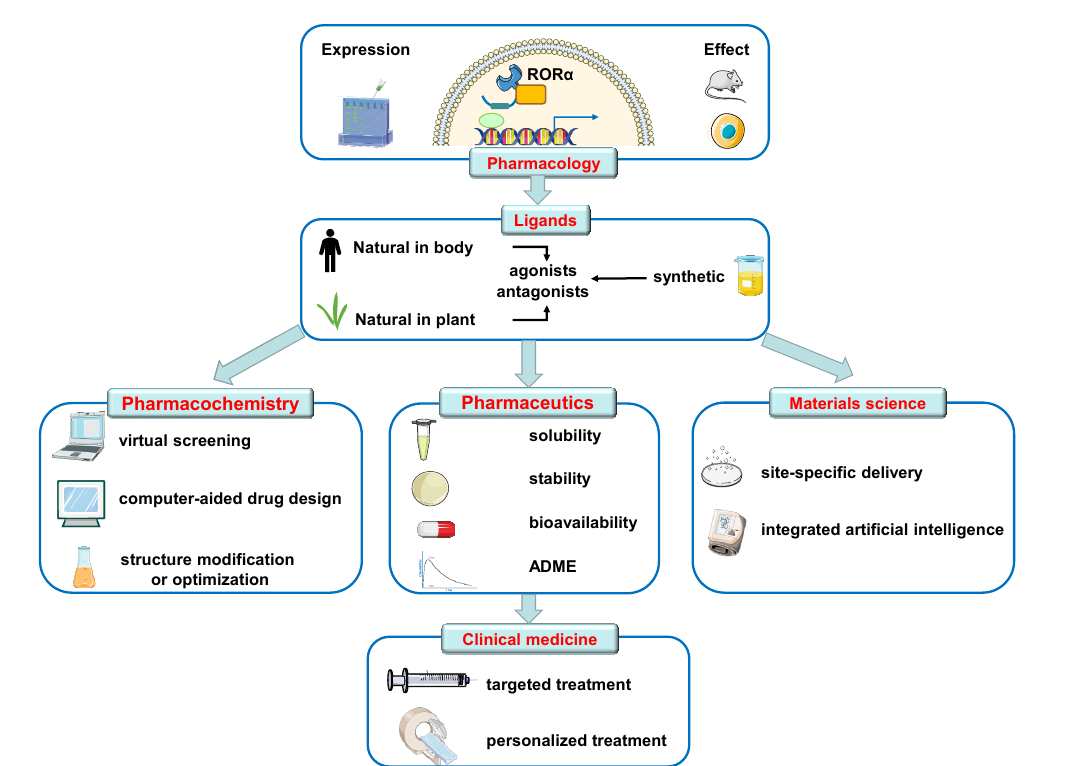
Figure 4. Further perspectives and strategies for ROR α -related drugs. With the deeper understanding of the pathophysiological function and mechanisms of ROR α in the cardiovascular system, protective pharmacological effects against a variety of cardiovascular diseases as a negative factor have been confirmed. Furthermore, exogenous agonists or antagonists without serious adverse reactions are possibly available to regulate the expression or activity of ROR α by pharmacological means. On the basis of known ligands, agonists, or antagonists, an “ROR α regulator” with better druggability and selectivity will be created via pharmacochemical strategies such as virtual screening and computer ‐ aided drug design. On the other hand, likely benefitting from the rapid development of materials science and pharmaceutical pharmaceutics, the solubility, stability, bioavailability, and absorption ‐ distribution ‐ metabolism ‐ excretion (ADME) of ROR α‐ related drugs are expected to be improved. In parallel, therapeutic strategies to regulate ROR α activity would be augmented by site-specific delivery, especially for the recently developed dual-targeting nanoagent enabling delivery of ROR α modulators to the heart and disease-associated blood vessels. Moreover, modern nanomedicine-integrated artificial intelligence offers opportunities for personalized treatment. Using the reticuloendothelial system will be beneficial to avoid macrophagy system capture, prolong blood circulation time, and achieve long-term effect. These potential strategies offer a good opportunity to provide targeted treatment for cardiovascular diseases by relevant ROR α drugs in a clinic